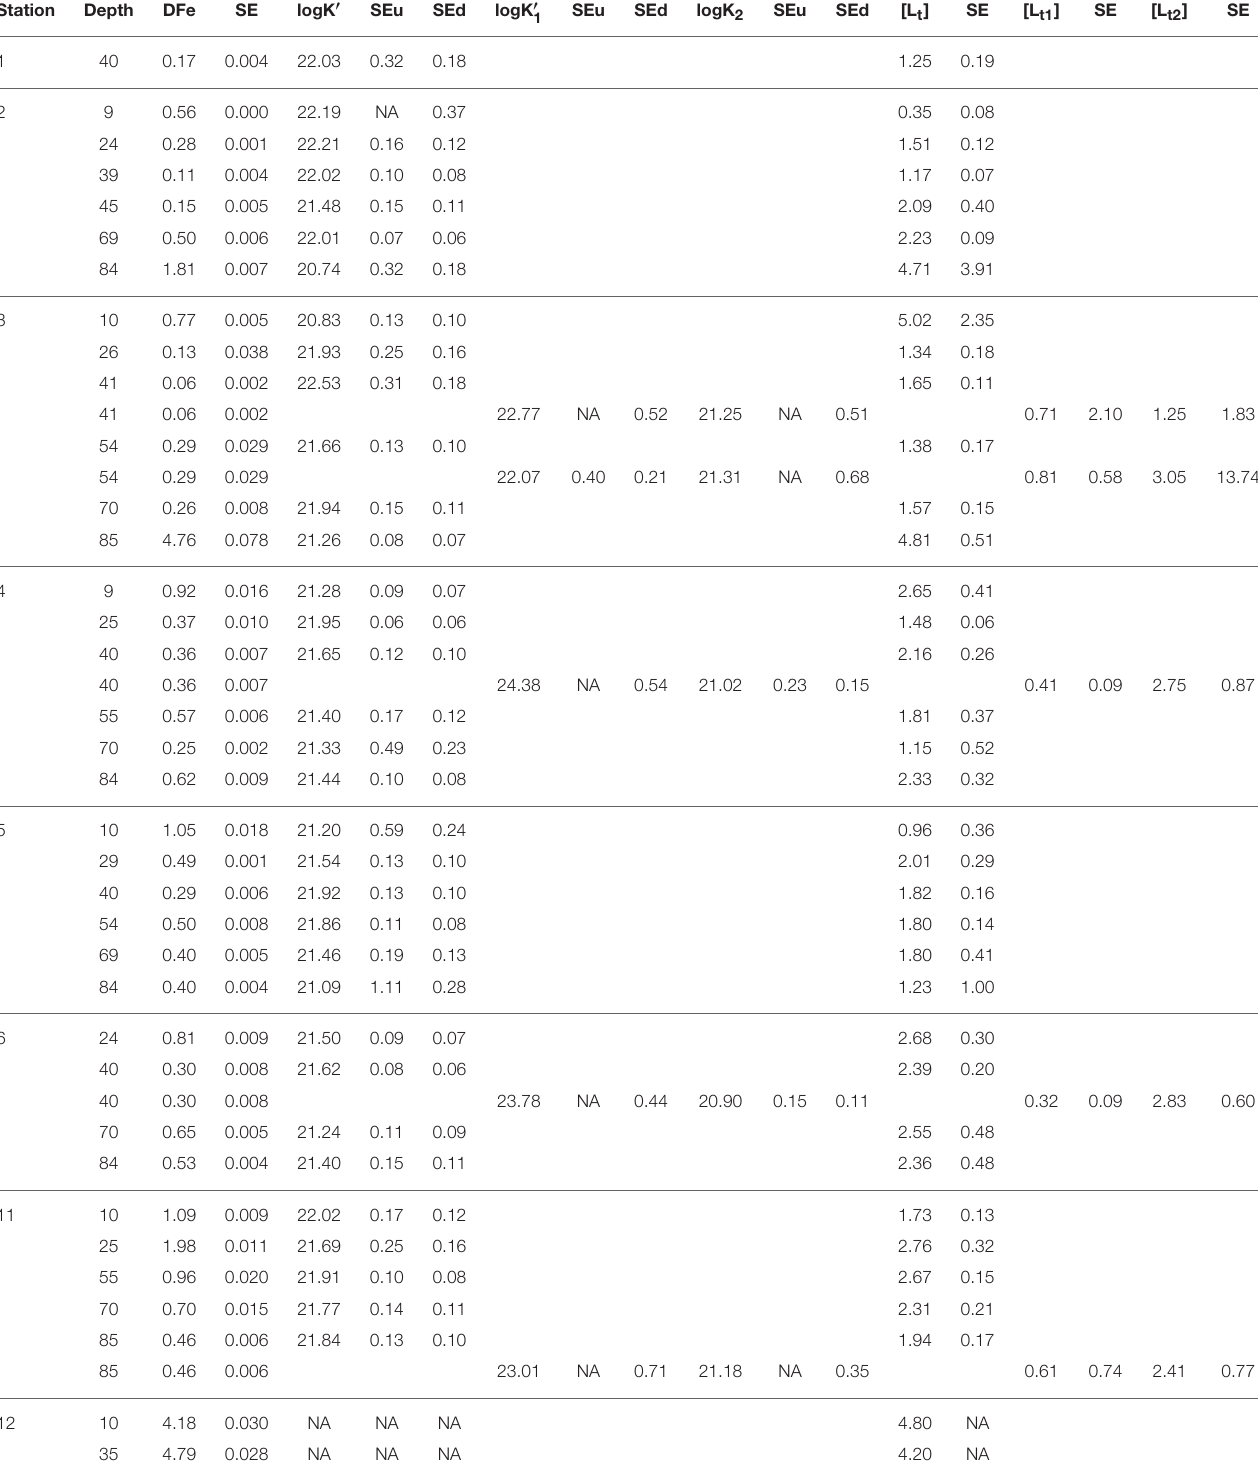
TABLE 1A | Dissolved Fe (DFe) in nM with standard error of the analysis, the ligand characteristics [L t ] (in nEq of M Fe) and logK ′ (M − 1 ) with standard error of the fitting of the Langmuir isotherm (Gerringa et al., 2014). Station